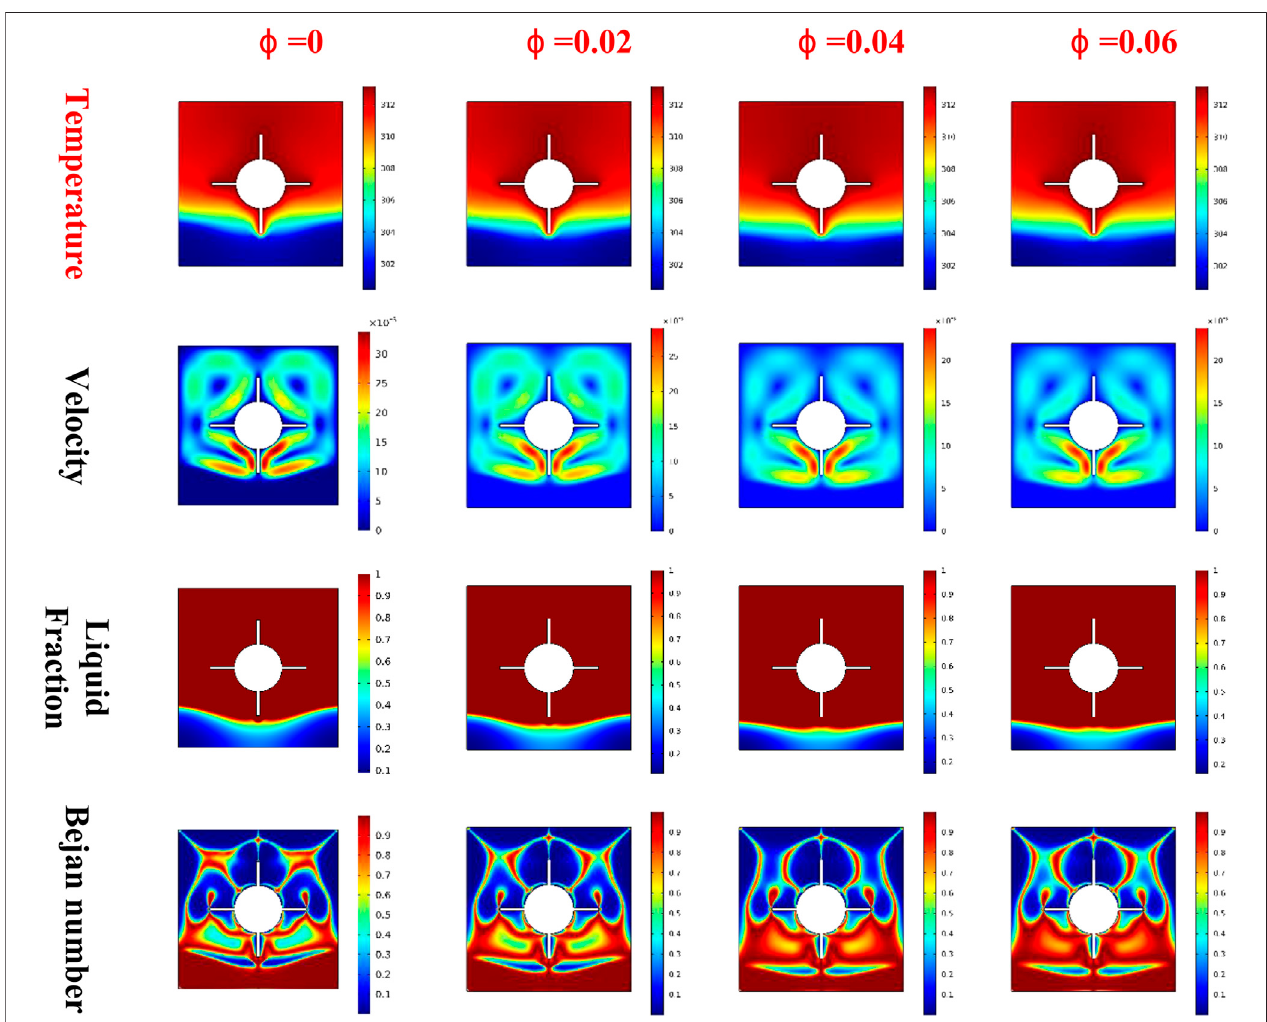
FIGURE 6 | Effect of nanoparticle concentration, liquid fraction, and Bejan number. during the PCM melting process at t (cid:1) 500s .